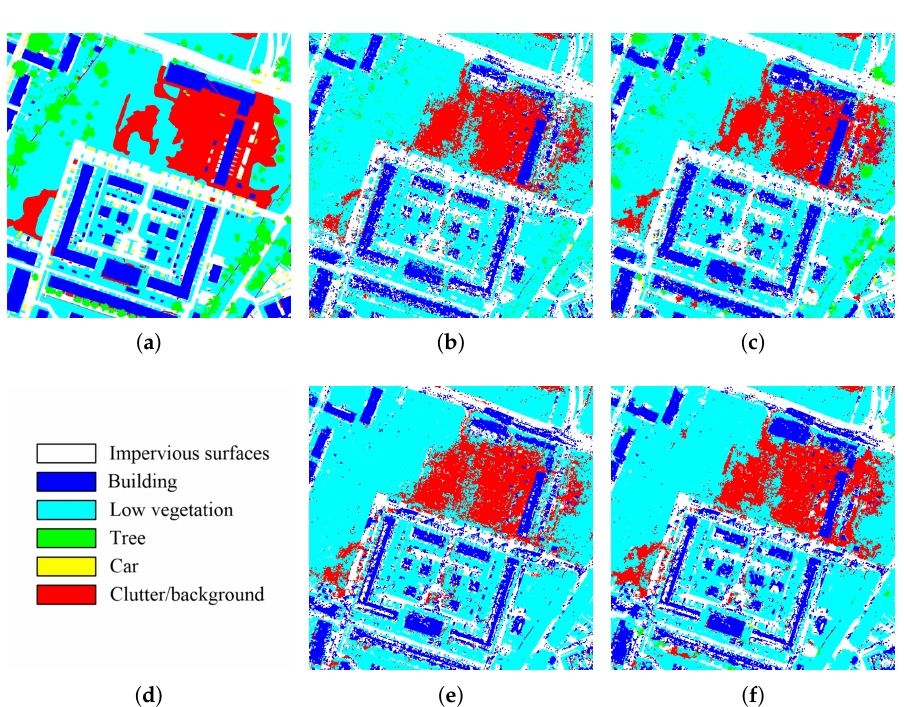
Figure 8. Classification maps generated from Potsdam-2_10: ( a ) ground truth; ( b ) XGB + BT;